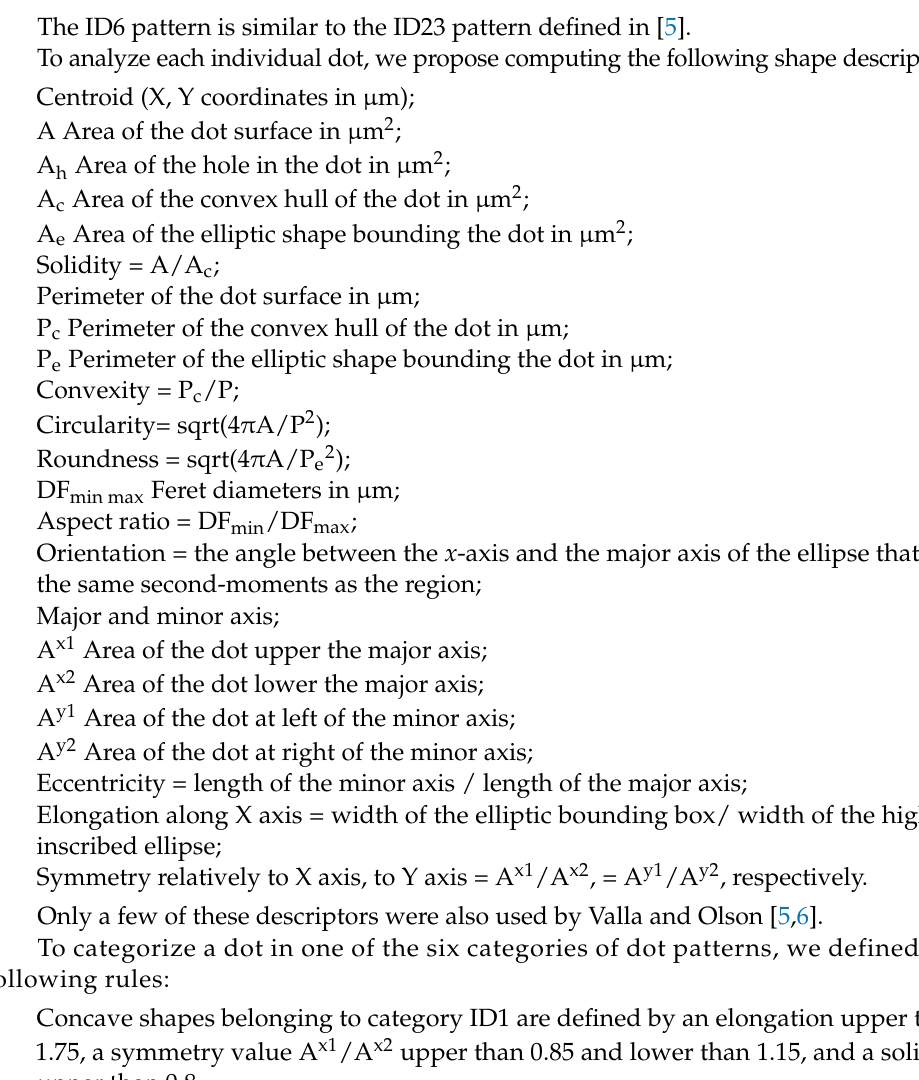
Figure 10. Categories of dot patterns (convex hulls of dots are highlighted in green, major/minor axis are highlighted in blue, convex hulls of holes are highlighted in red).